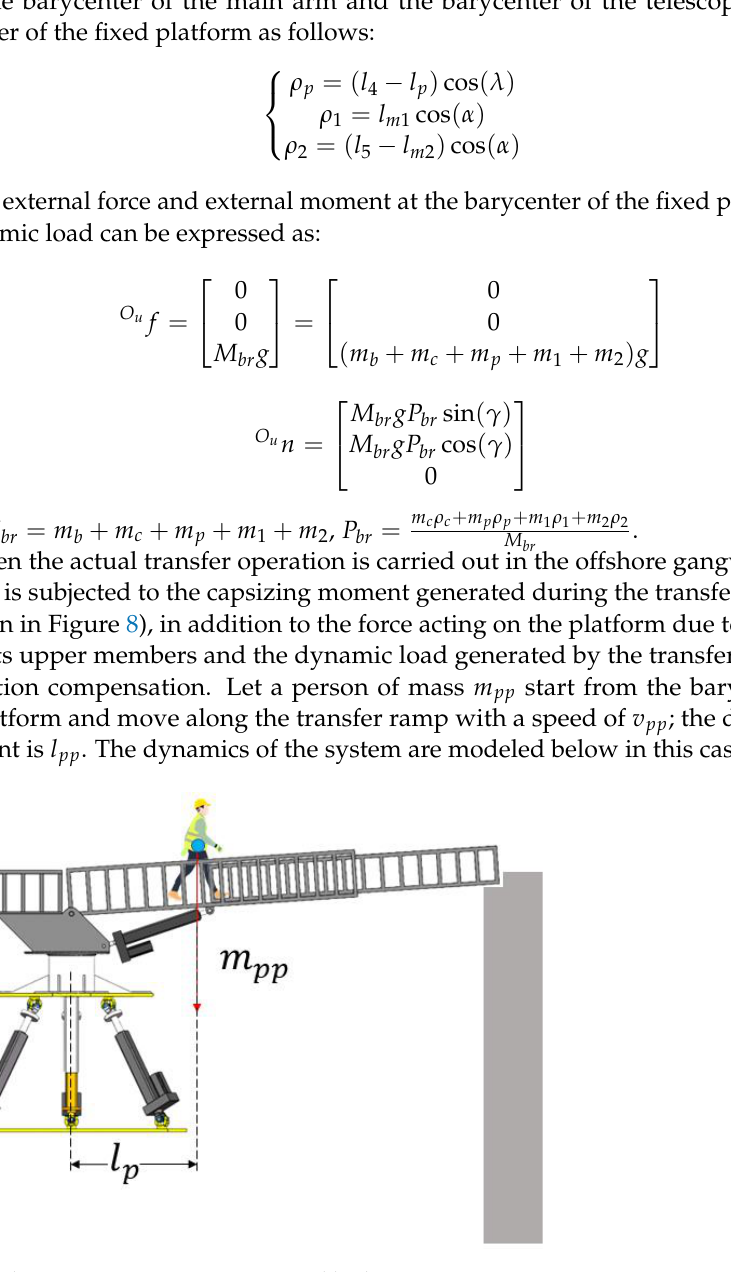
Figure 8. The capsizing moment generated by human movement. During the transfer process, the person’s translational movement along the trans- fer gangway is accompanied by the rotary motion of the slewing mechanism, then the barycenter of the person in the o u − x u y u z u frame can be expressed